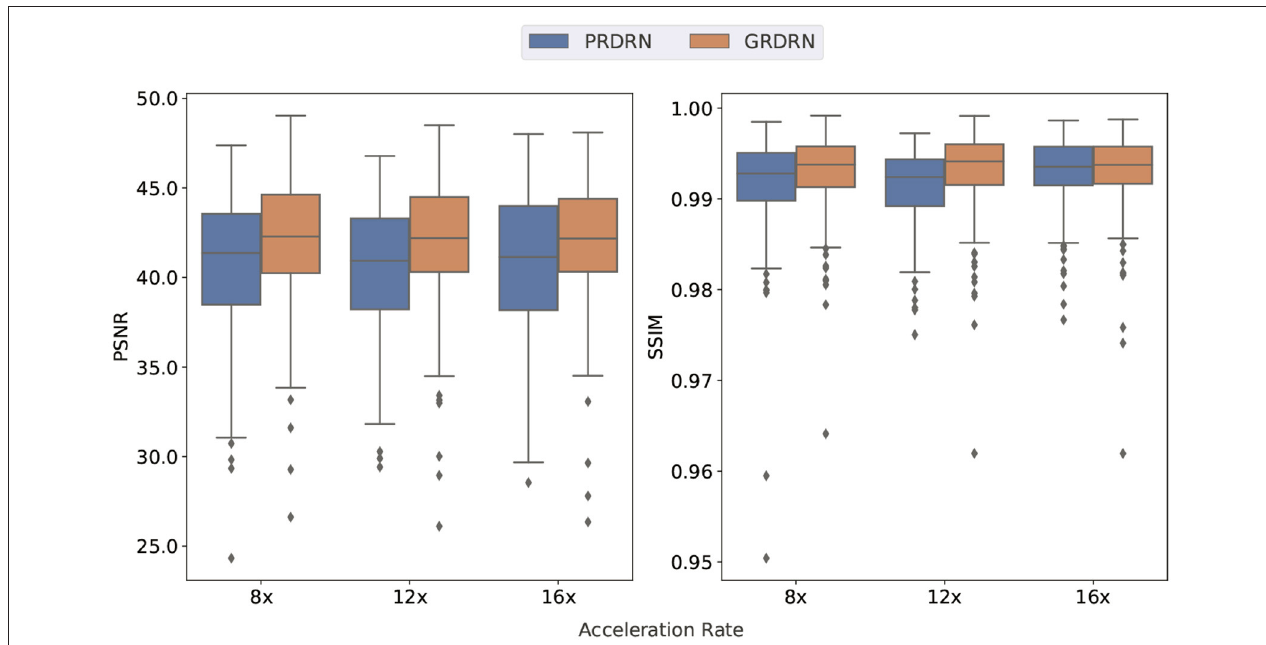
FIGURE 7 | Box plots of PSNR and SSIM for the registration task with pairwise (PRDRN) and groupwise (GRDRN) registrations, where the metrics are reported between generated dynamic image sequences and the original